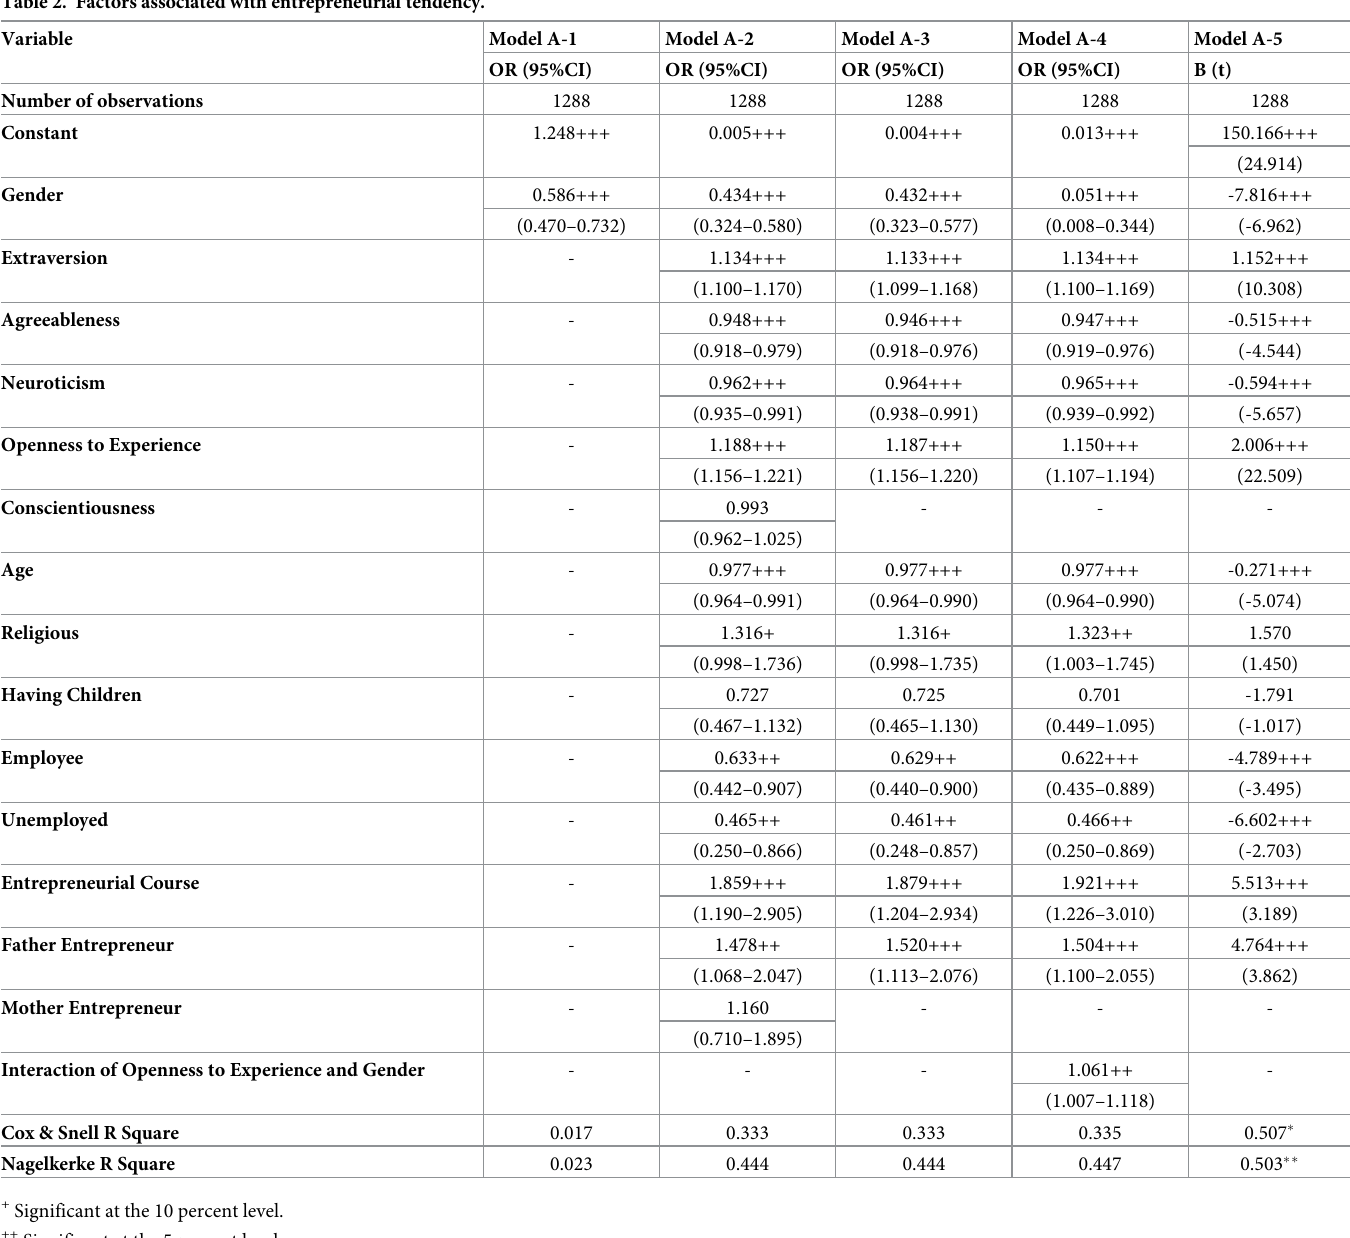
Table 2. Factors associated with entrepreneurial